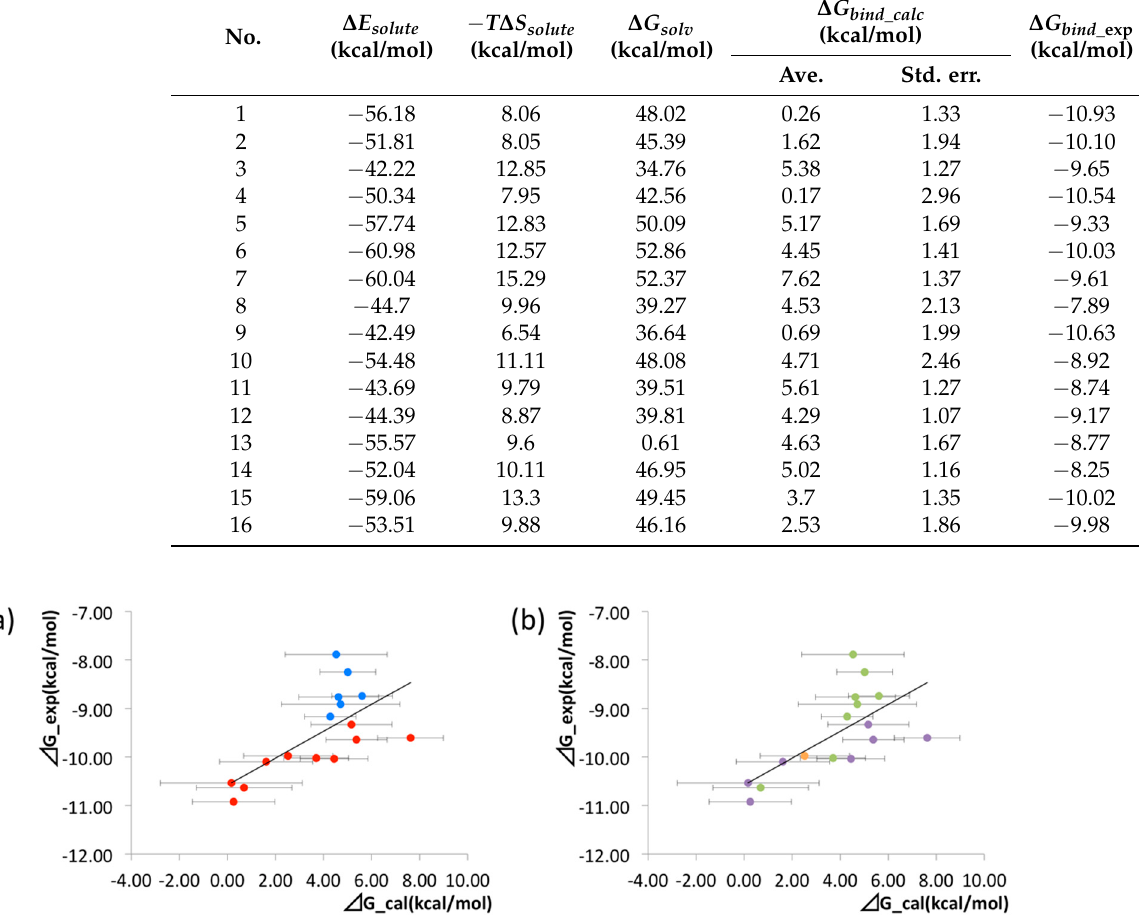
Figure 12. Correlation between calculated and experimental values of binding free energy for all the ligands. Correlation coefficient R = 0.69. The figures are colored in different manners based on the structural feature of the ligands. ( a ) Ligands that include CF 3 on the meta position of the phenyl ring are colored with red. Other ligands are colored with blue. ( b ) Ligands that have cyclo-hexane, cyclo-butane, and cyclo-propane are colored with purple, orange, and green, respec-tively. (The figure is reprinted from Ref. [16]. Copyright (2017) American Chemical Society).